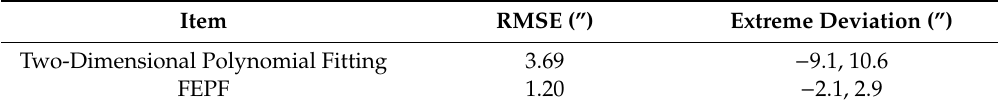
Table2. Compensationresultsoftwo-dimensionalpolynomialfittingandFourierexpansion-polynomial fitting